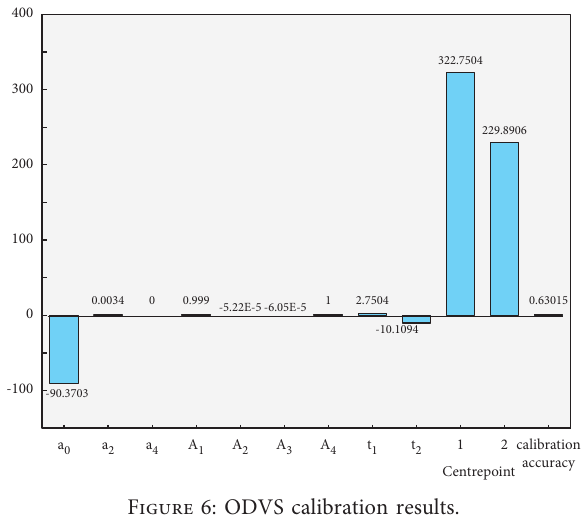
Figure 6: ODVS calibration results.